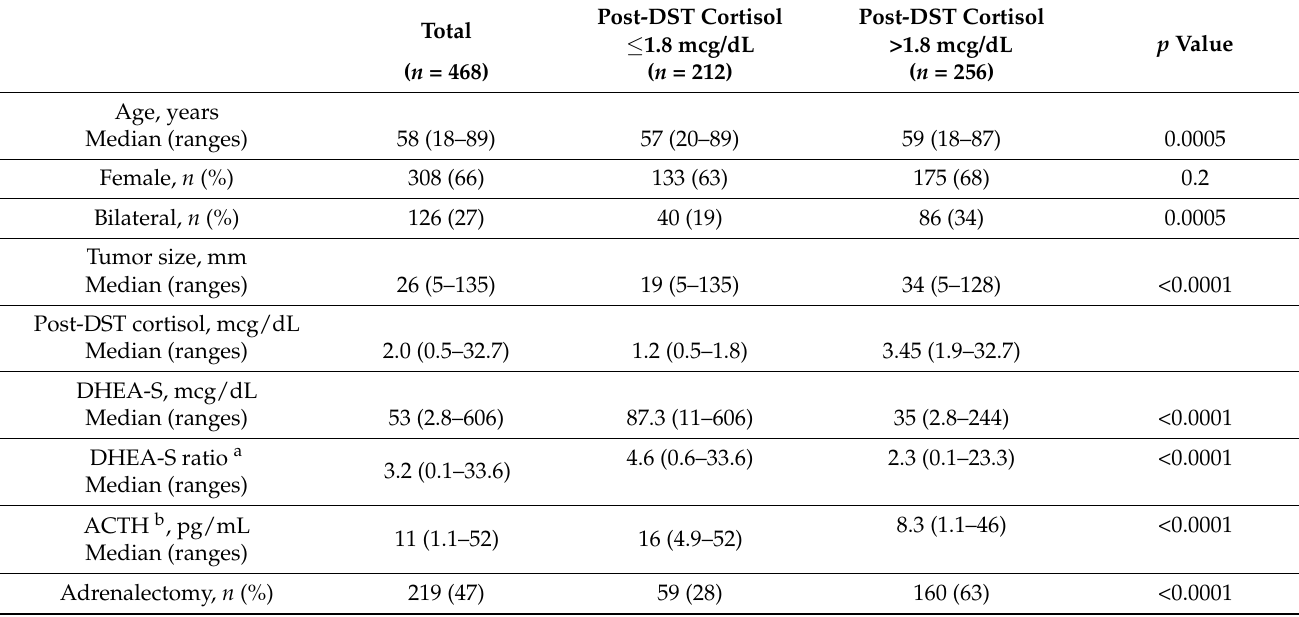
Table 1. Clinical and biochemical presentation of patients with adrenal adenomas based on the 1-mg overnight dexametha- sone suppression test